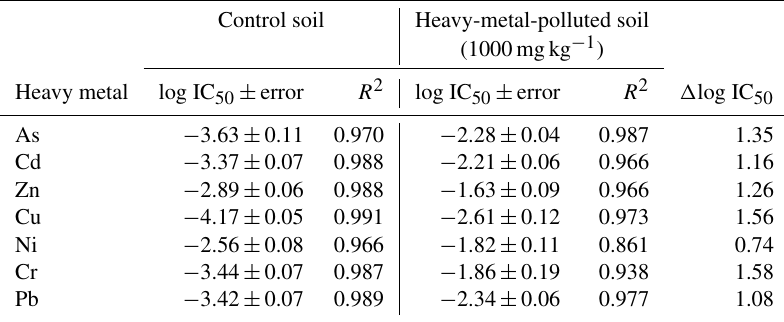
Table 2. Estimated values of log IC 50 ± error and R 2 from fits to a logistic model of soil samples containing 0mgkg − 1 (control soil) and 1000mgkg − 1 of As, Cd, Zn, Cu, Ni, Cr, or Pb (individually). The increases in tolerance ( (cid:49) log IC 50 = log IC 50 polluted − log IC 50 control) were calculated for each heavy